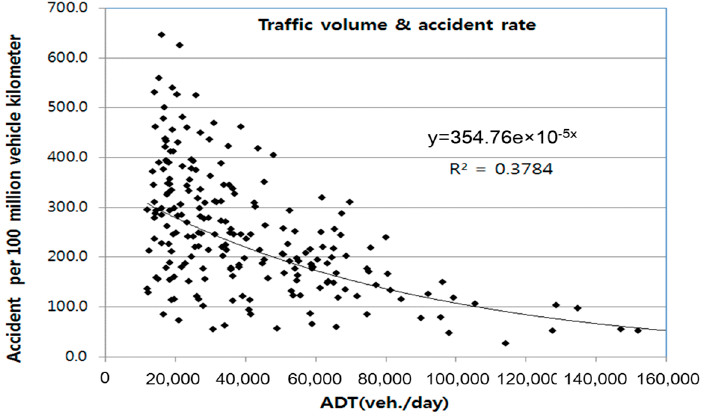
Figure 12. Accident rate as a function of the average daily traffic volume.